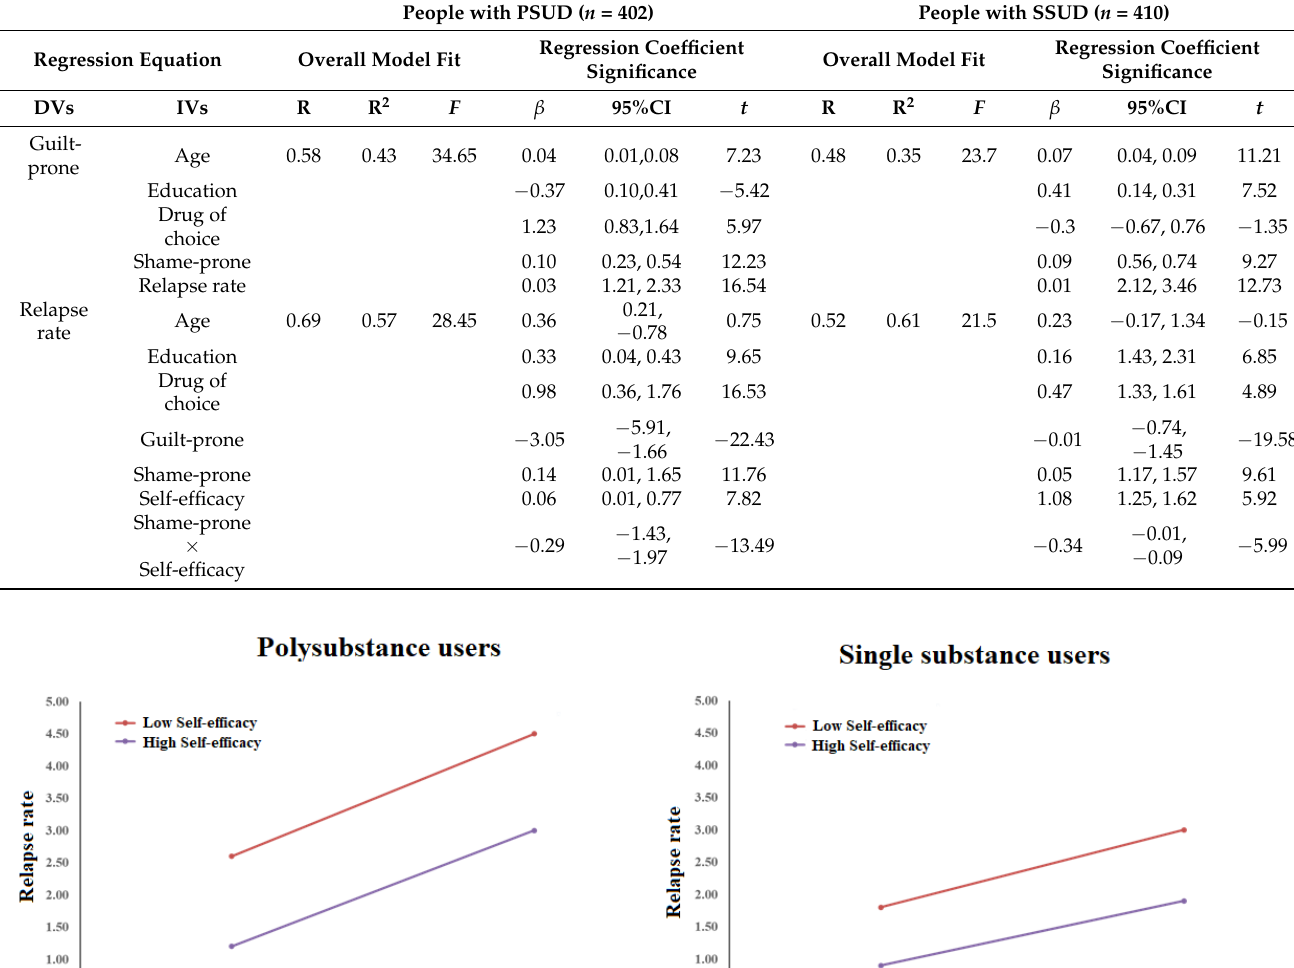
Table 4. Mediation and moderation results of the variables between people with PSUD and SSUD.